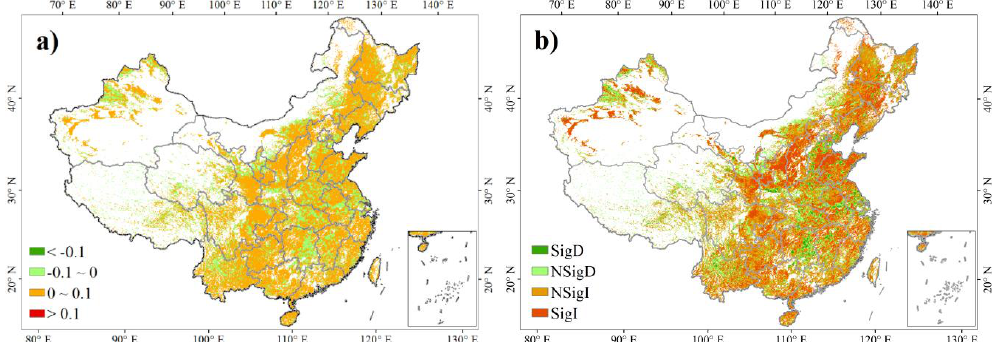
Figure 5. The spatial distribution of cropping intensity trends for each pixel within 5 km grids are shown for ( a ) changing rates in linear trends from 2001 to 2016 and ( b ) significances in linear trends from 2001 to 2016 (significantly increasing, SigI; increasing but not significant, Non-SigI; decreasing but not significant, Non-SigD; significantly decreasing, SigD).